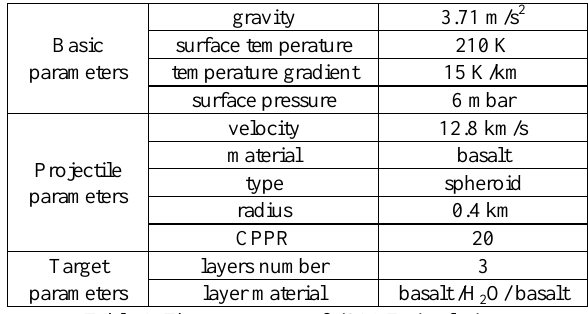
Table 1. The parameters of iSALE simulations